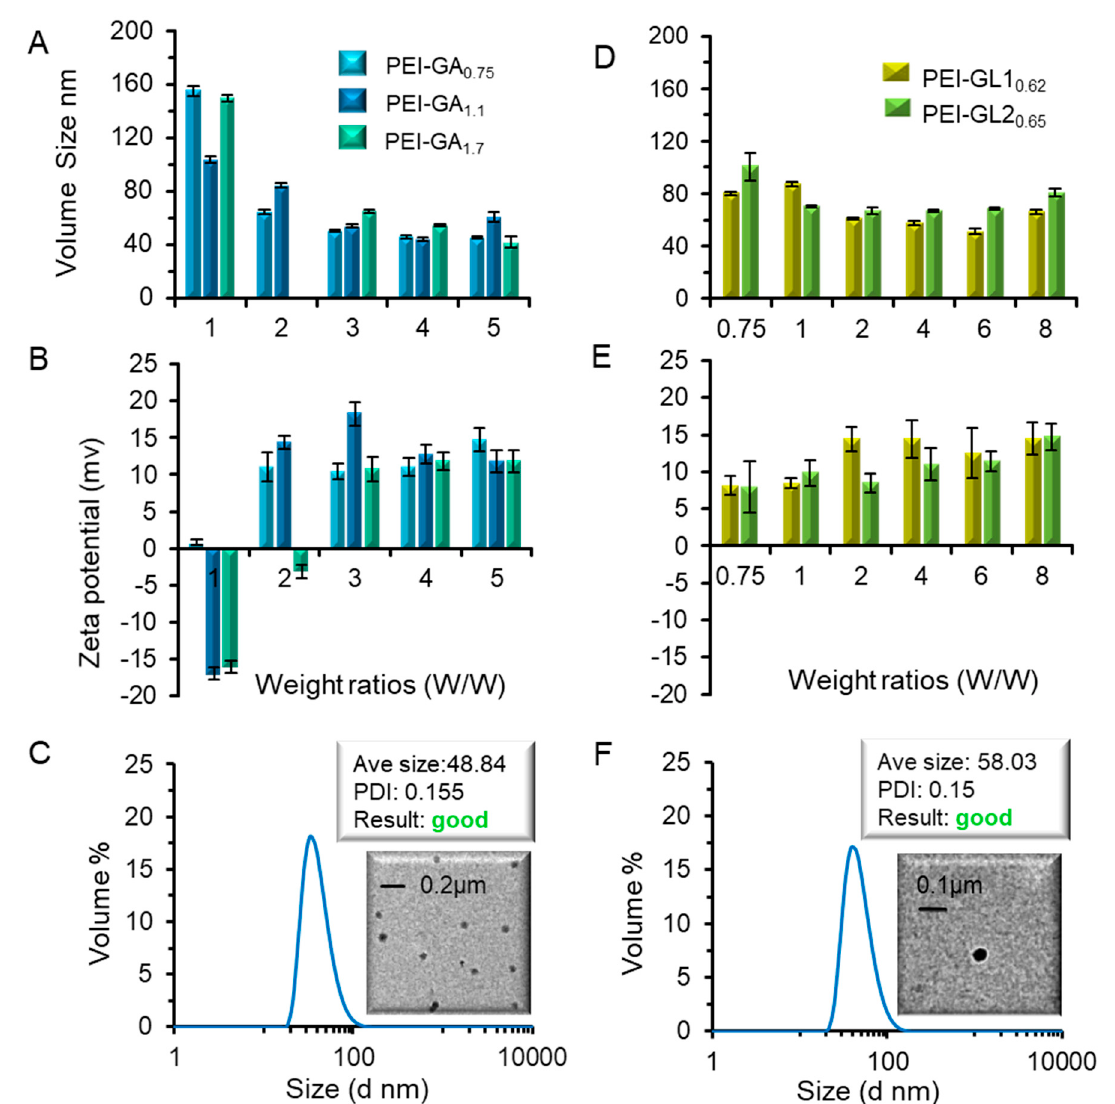
Figure 3. Sizes and zeta potentials of PEI-GA and PEI-GL polyplexes. ( A , D ) Sizes and ( B , E ) Zeta potentials of PEI-GA ( A , B ) and PEI-GL ( D , E ) polyplexes at various weight ratios. ( C , F ) Volume size distribution of PEI-GA 0.75 / pLUCI and PEI-GL1 0.62 / pLUCI at weight ratio of 3, and their morphologies observed by TEM after staining with phosphato-tungstic acid (PTA). Scale bar 100 nm.